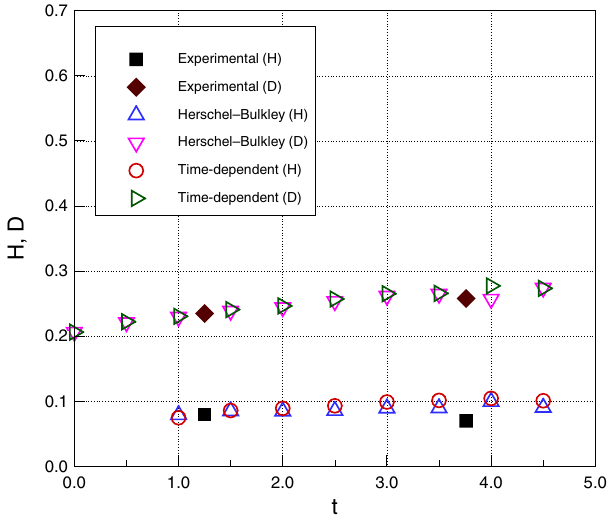
Figure 19. Subaqueous debris case 1: flow-front velocity ( U , ms − 1 ) as a function of simulation time ( t ,